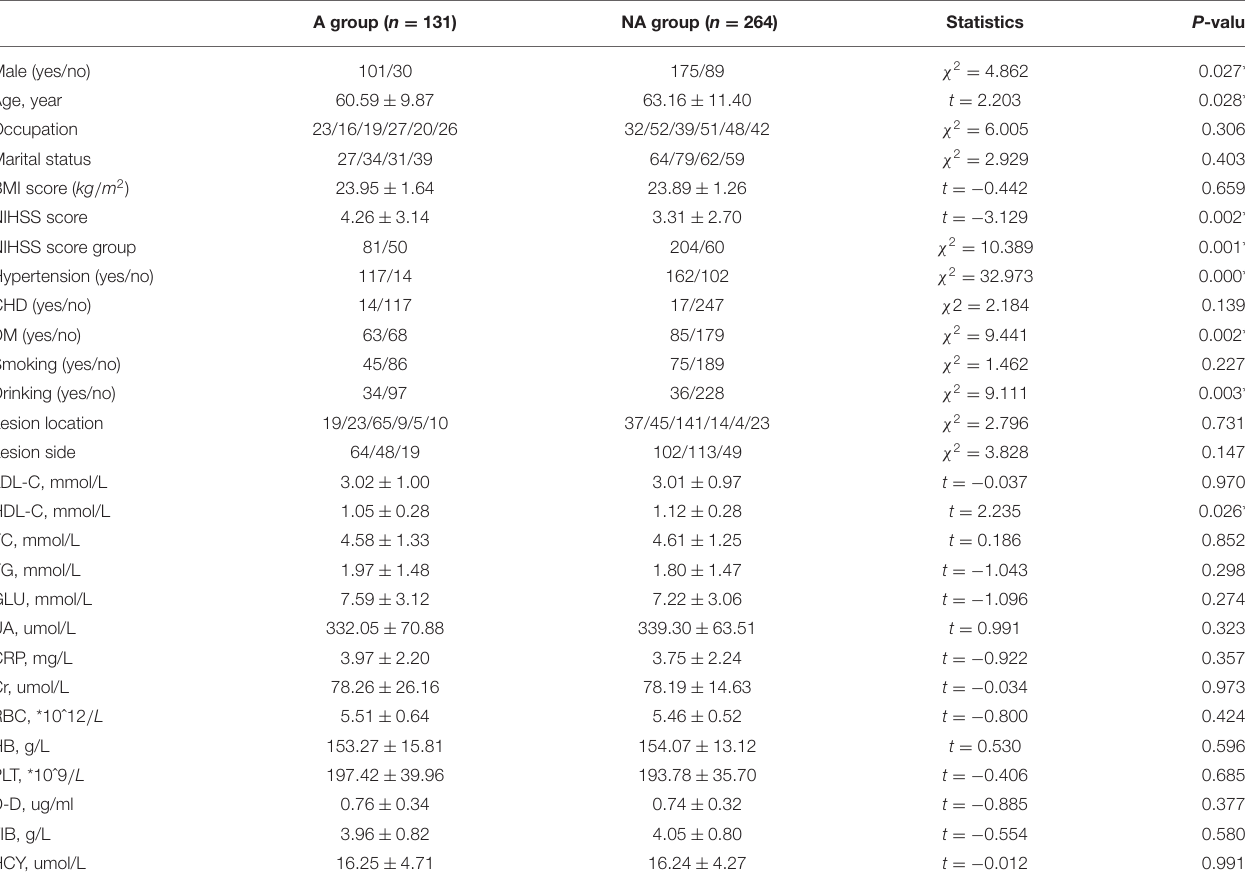
TABLE 1 | Significant characteristics between patients with and without post-stroke anxiety (PSA) by Hospital Anxiety and Depression Scale (HADS-A) ( n =